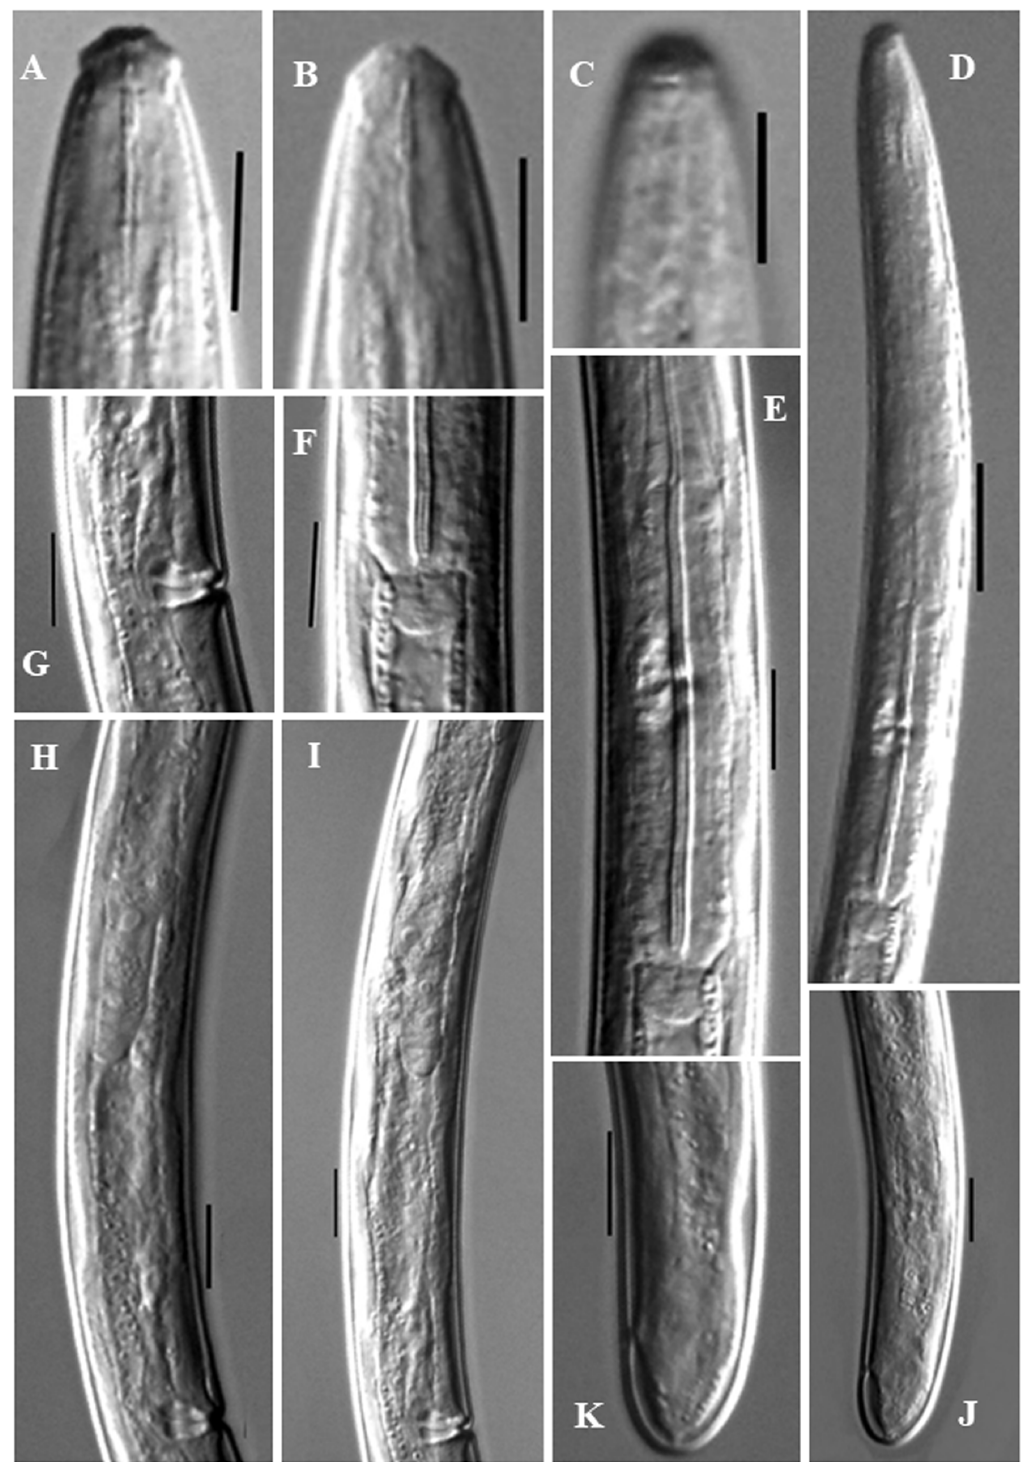
Fig. 4. Tylencholaimus micronanus Yeates, 1979, ♀ (LM photographs). A–B . Anterior region. C . Anterior region showing amphid. D . Pharyngeal region. E . Expanded part of pharynx. F . Pharyngo-intestinal junction. G . Vulval region. H–I . Genital system. J . Posterior region. K . Posterior end. Scale bars: A–C, E–K = 10 μm; D = 20